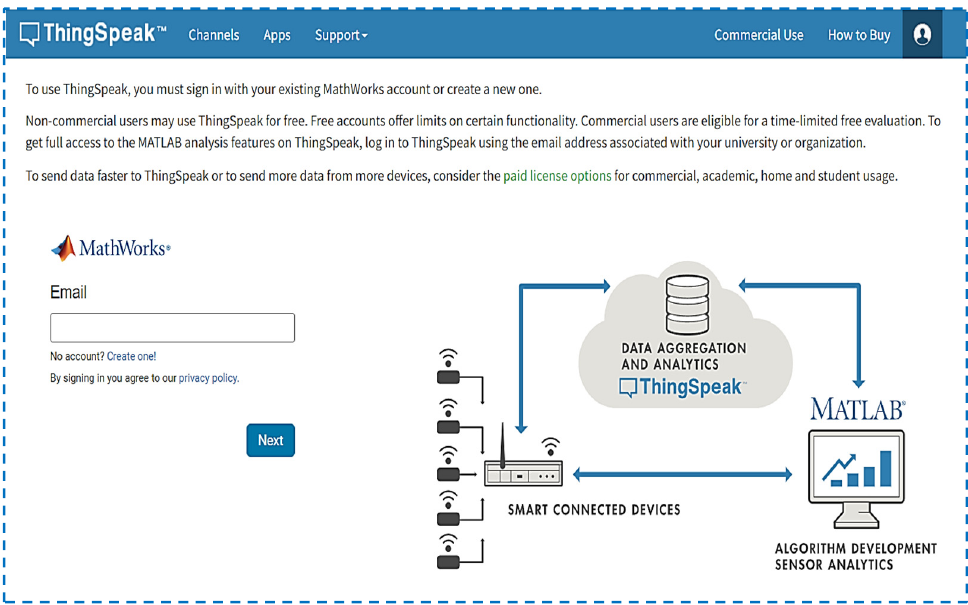
Figure 3. Platform for creating user interfaces (ThingSpeak platform).